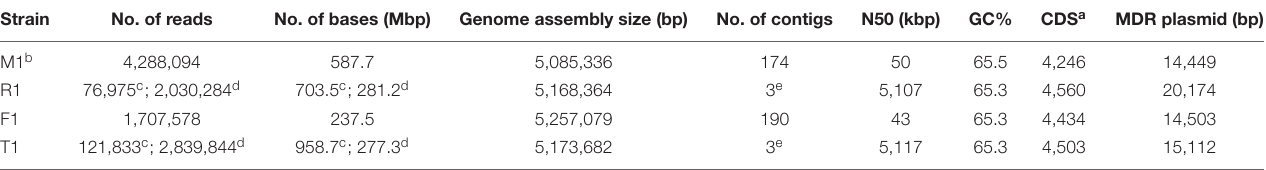
TABLE 3 | Genome statistics of four oxytetracycline- and streptomycin-resistant Xanthomonas arboricola pv. pruni ( Xap ) strains.